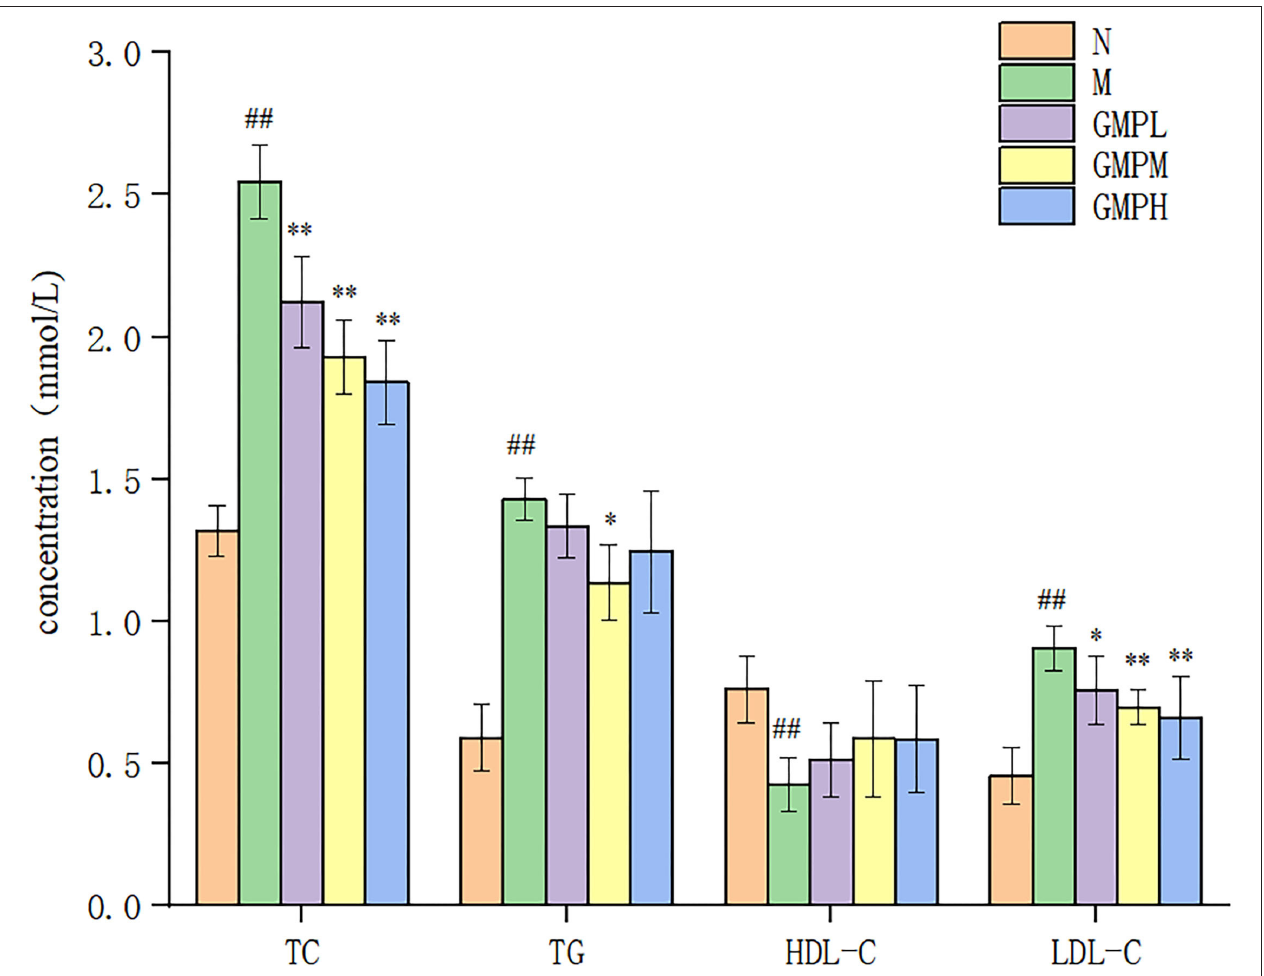
FIGURE 3 | Effects of different doses of GMP on TC, TG, HDL-C, and LDL-C levels. The data in the figure are expressed as mean ± SD ( n = 6). Significance of difference: *means p < 0.05, **means p < 0.001, compared with group M. ## means p < 0.001, compared with group N. GMP, germinated mung bean polyphenol; TC, total cholesterol; TG, triglycerides; HDL-C, high-density lipoprotein; HDL-C, low-density lipoprotein (LDL-C), ALT, alanine aminotransferase; AST, aspartate